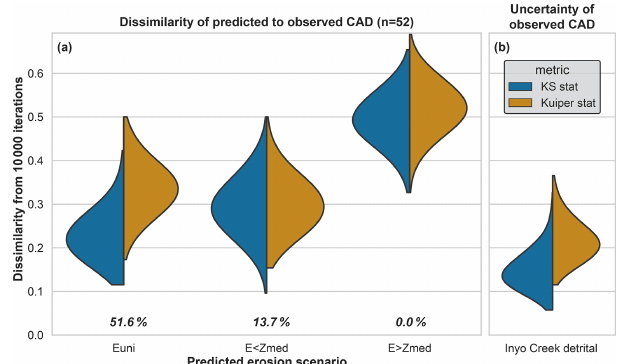
Figure 8. Violin plot showing the KS (and Kuiper) statistics be- tween the predicted CAD of each erosion scenario and observed CAD, calculated for 1000 n = k = 52 subsamples (a) . KS (and Kuiper) statistics between the observed CAD and 10000 random n = k = 52 distributions, drawn from the same detrital age popu- lation but including uncertainty (b) . Every violin is split in two halves with equal area, each representing the probability distribu- tion function of 10000 KS (or Kuiper) statistics. The widest point of each semi-violin informs the most frequent KS (or Kuiper) statis- tic. The closer this value is to zero, the more similar the scenario is to the observed detrital age distribution. The most unlikely sce- nario is “ E > Z med ”. Both other scenarios are plausible because their dissimilarity to the observed CAD largely overlaps the range of dissimilarity due to analytical error of the detrital ages.